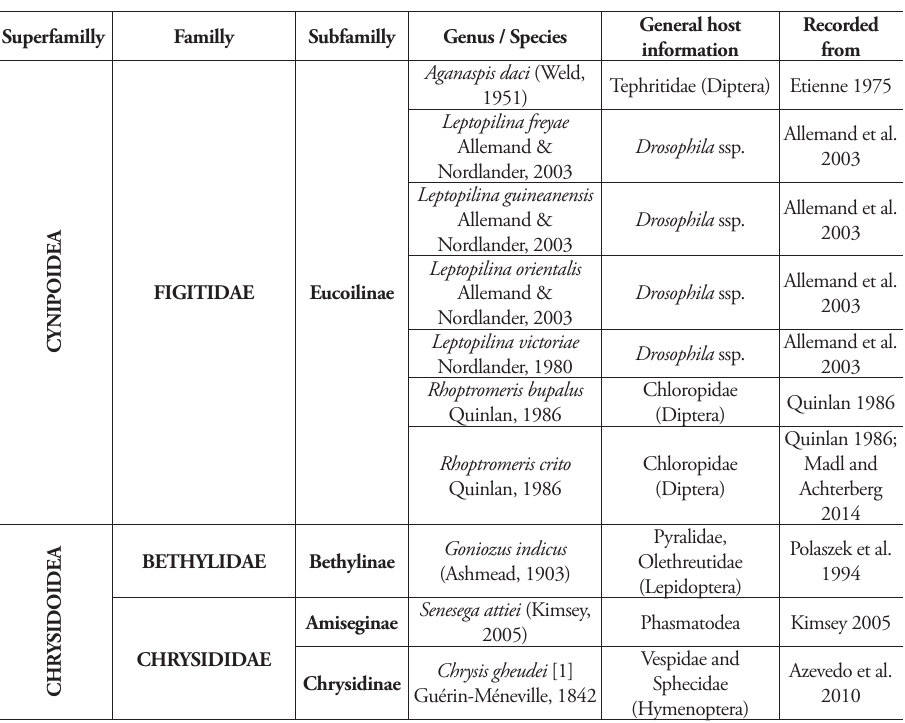
Table 3. List of the Cynipoidea, Chrysidoidea, Platygastroidea, Diaprioidea, Ceraphronoidea and Evanioidea recorded from Reunion Island.